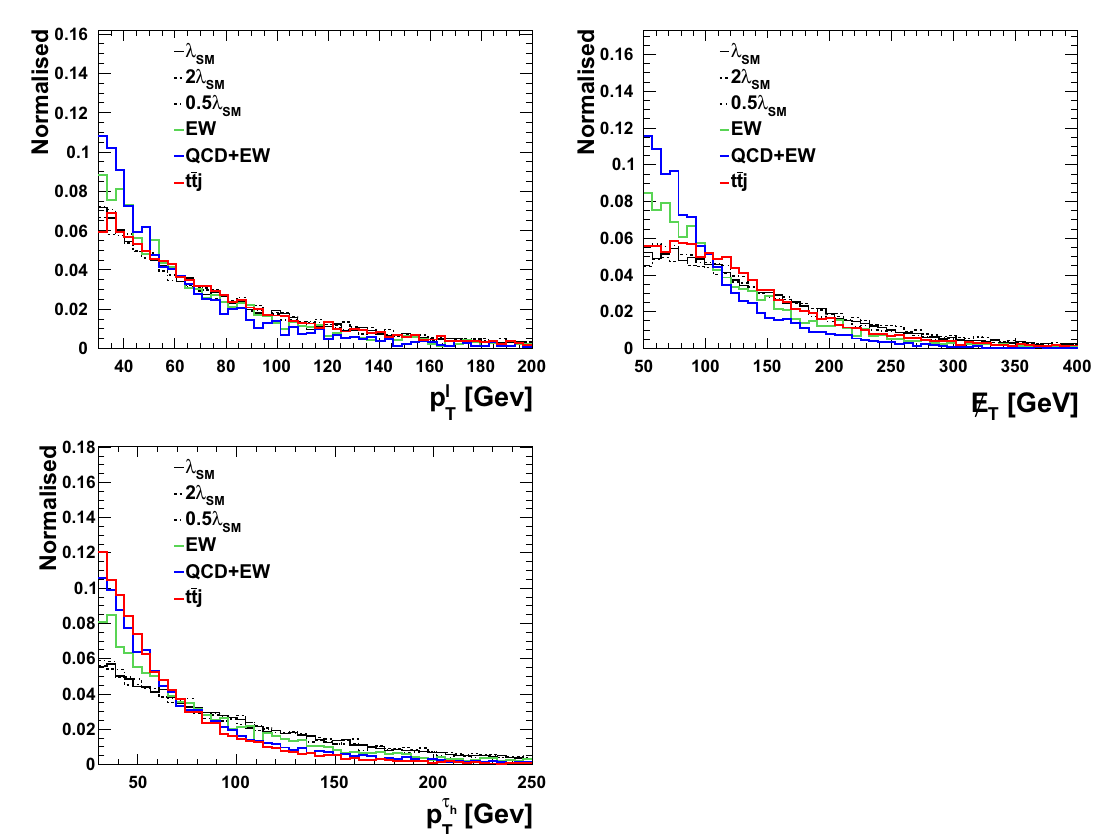
Fig. 3 Normalised differential transverse momentum contributing to the τ (cid:3) τ h BDT analysis